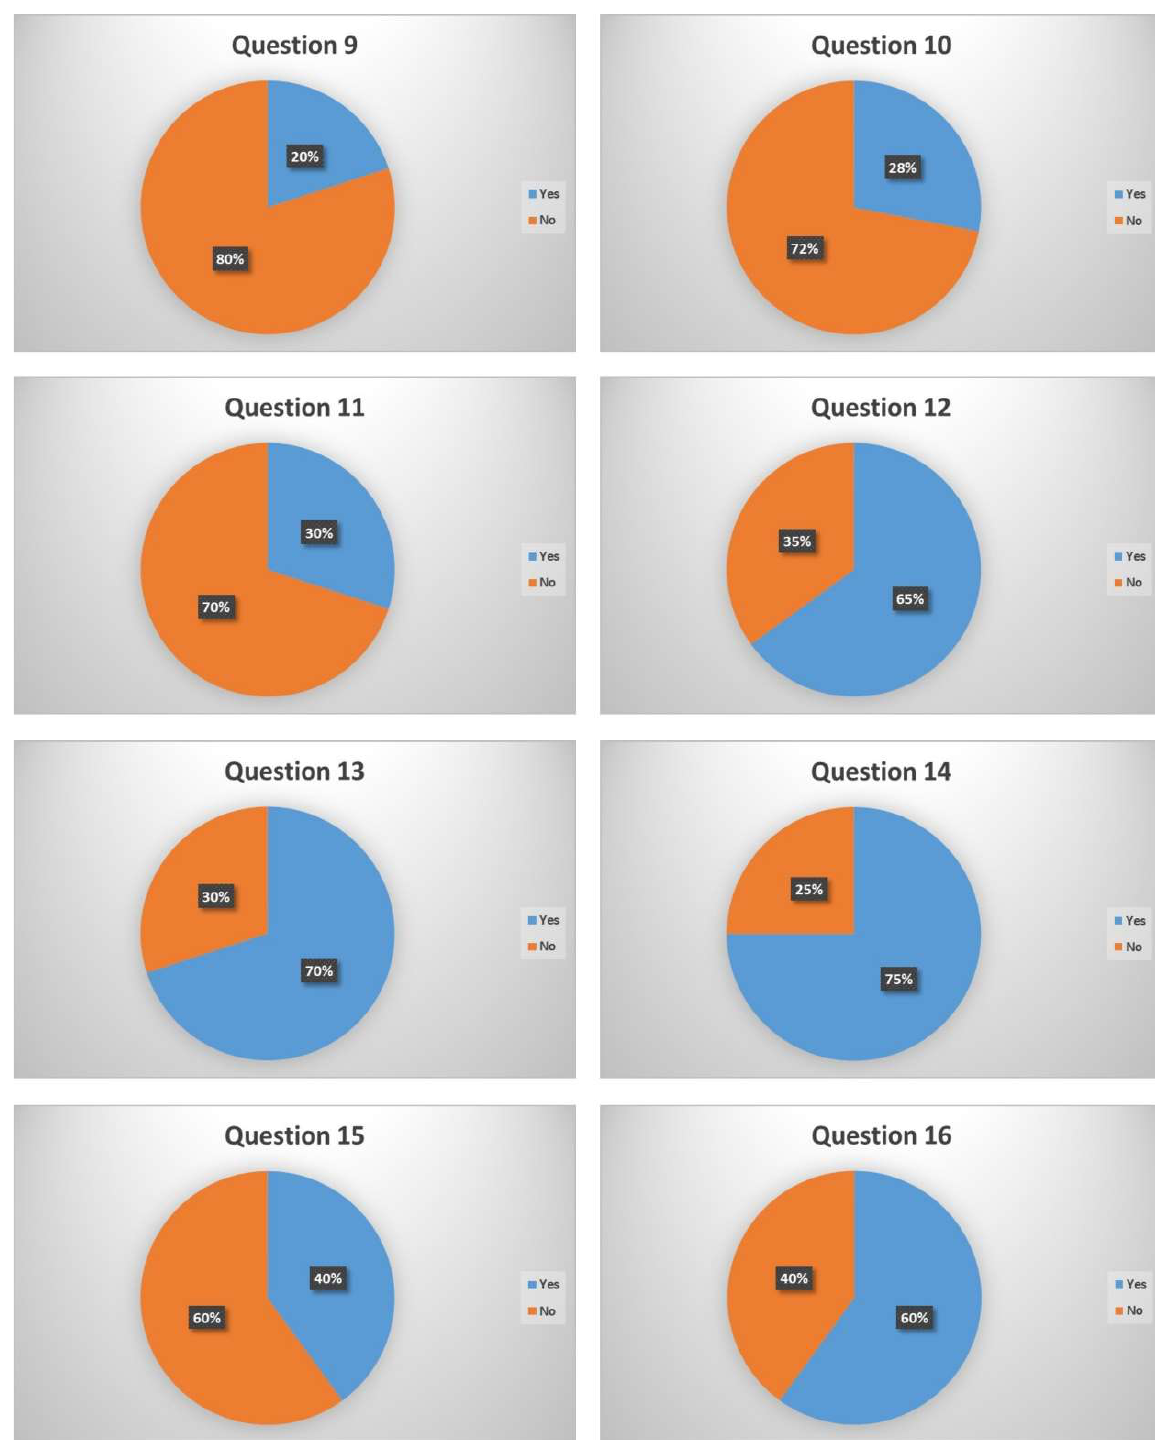
Figure 7. Excel pie charts showing the answers from the questionnaires (answers to questions 9 to 16).